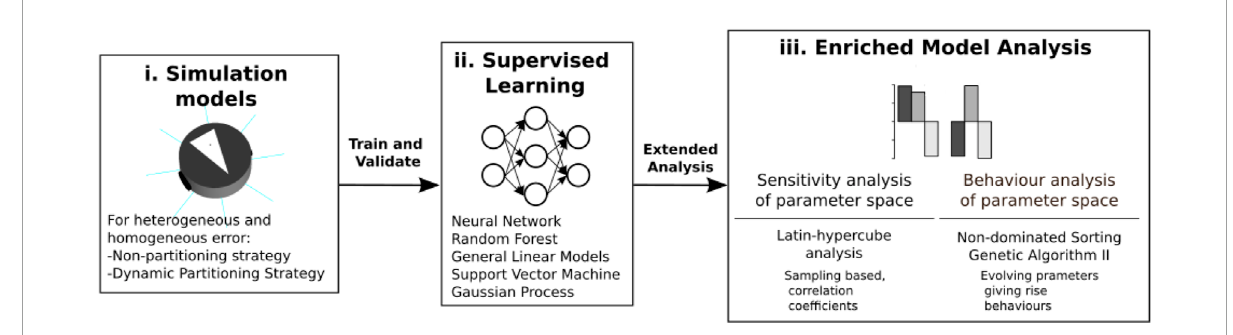
FIGURE 3 From simulation to emulation block diagram. A dataset is generated from Latin hypercube analysis in simulations (i). This dataset is used to train and validate the ensemble composed with different machine learning techniques (ii). Different statistical tools are used to analyze the ensemble model